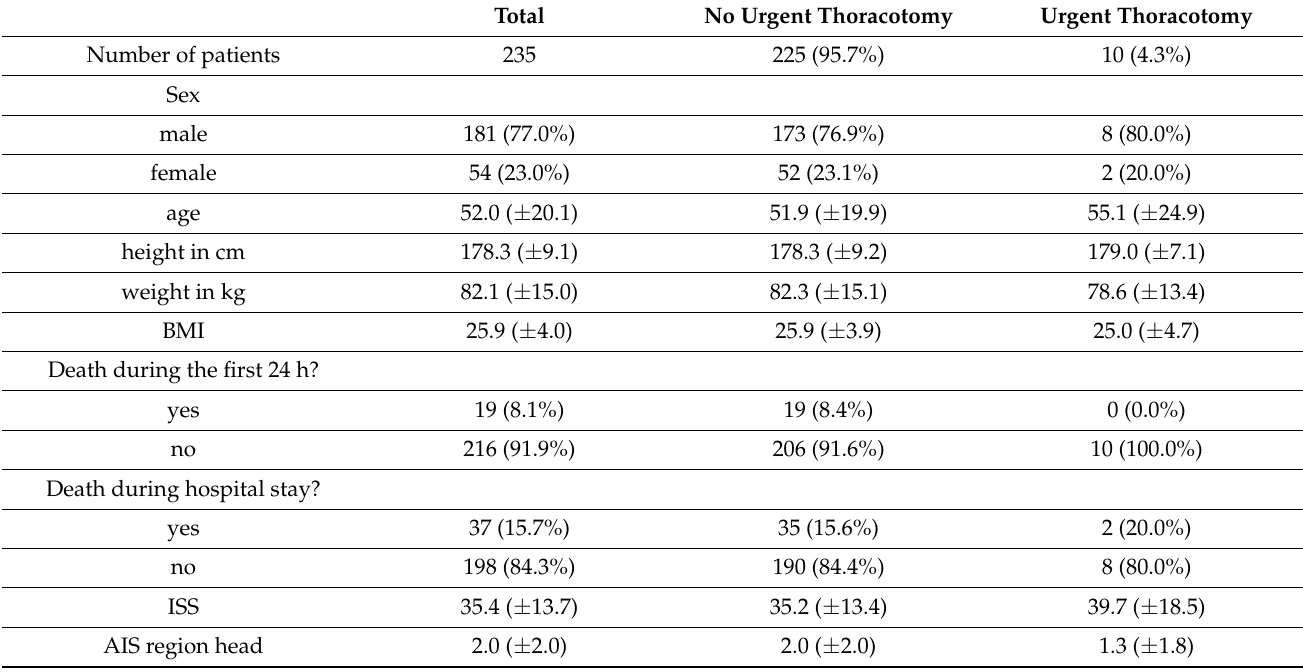
Figure 1. Flow diagram summarizing patient selection. Table 1. Baseline characteristics of study population.